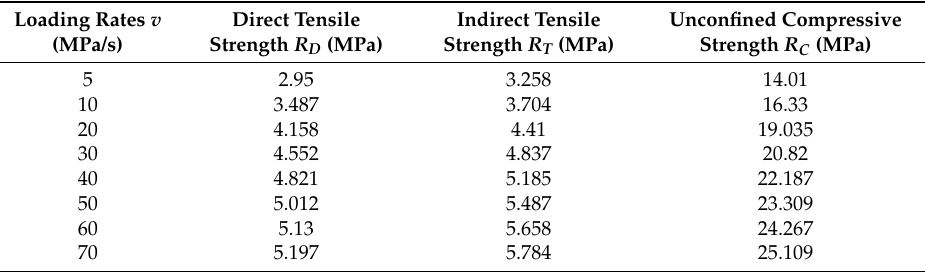
Table 9. Strength values of different loading rates under various loading modes.